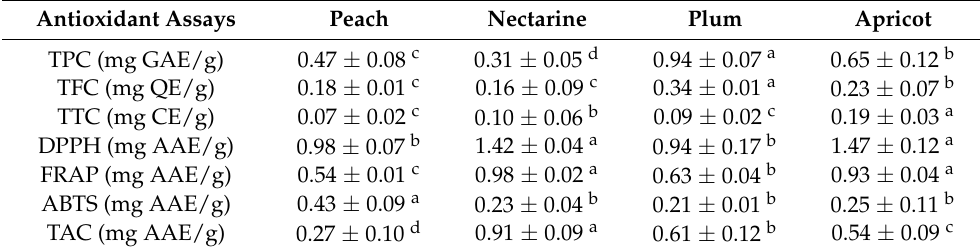
Table 1. Phenolic content and antioxidant activities in stone fruit samples. Antioxidant Assays Peach Nectarine Plum